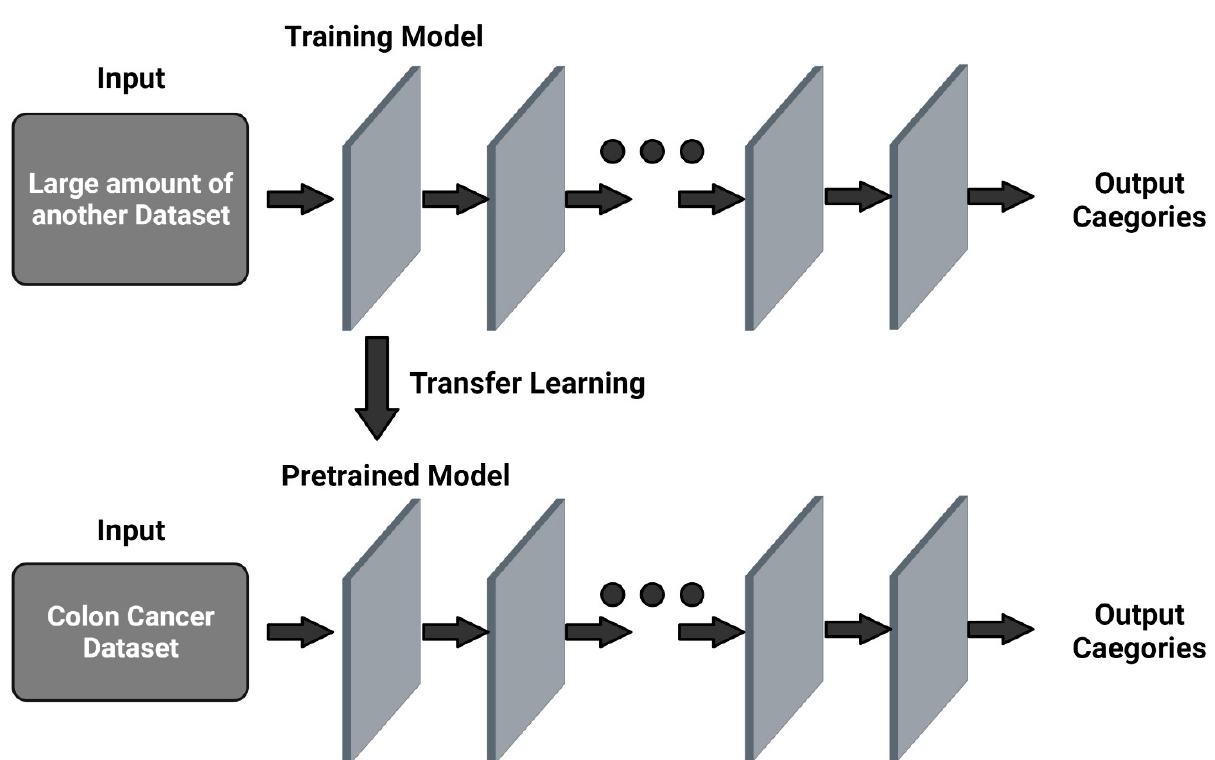
Figure 2. An overview of transfer learning model. Created with BioRender.com (accessed on 1 July 2022).